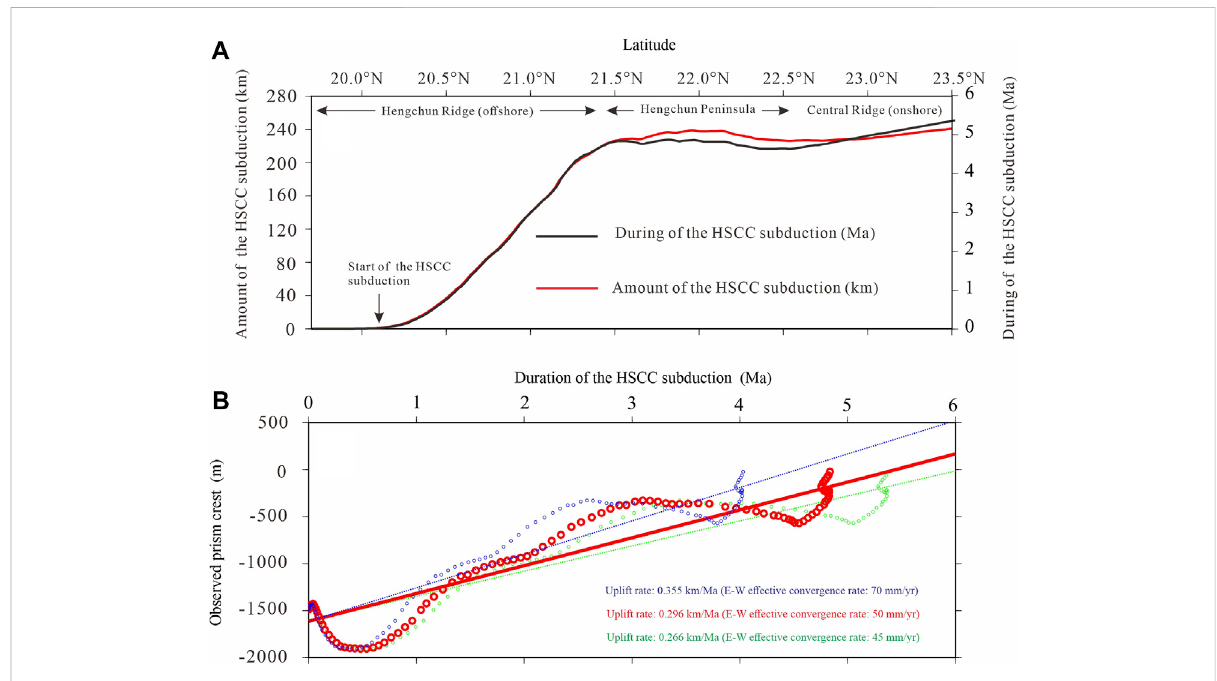
FIGURE 3 (A) Amount and duration of hyper-stretched continental crust (HSCC) subduction. The start of HSCC subduction occurs at 20.2 ° N. For Hengchun Ridge, the amount and duration of HSCC subduction increases from 0 to 220 kmand 0to 5 Ma,respectively. Forthe onshore Hengchun PeninsulaandCentralRidge,theamountanddurationremainconstantat240 kmand5 Ma,respectively. (B) Correlationbetweenthedurationofthe HSCC subduction and observed crest of the prism over Hengchun Ridge. The red circle shows the correlation based on the E-W effective convergence rate of 50 mm/yr, and a red solid line indicates a best- fi t line. The green and blue circles and dashed lines represent the correlation based on the E-W convergence rate of 45 and 70 mm/yr, respectively. The positive correlation suggests that the uplift of Hengchun Ridge is dominated by the accretion of HSCC